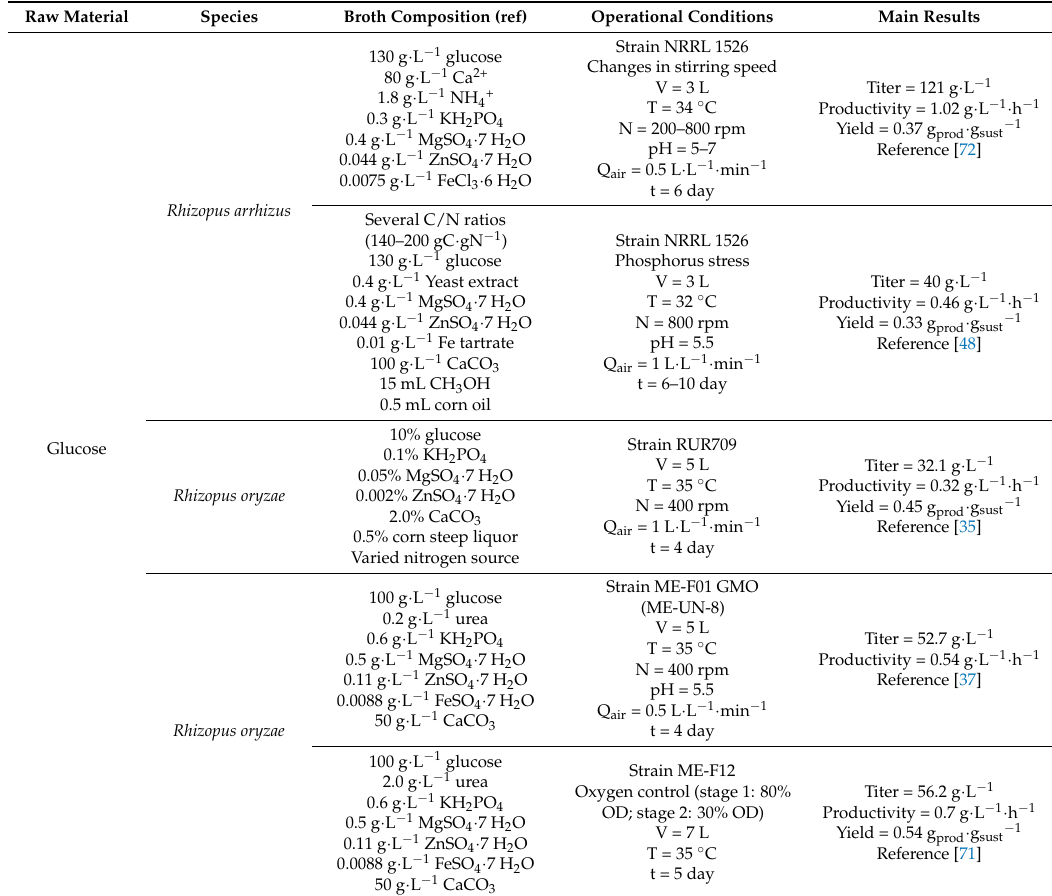
Table 1. Main results in batch (tank) bioreactors with overhead